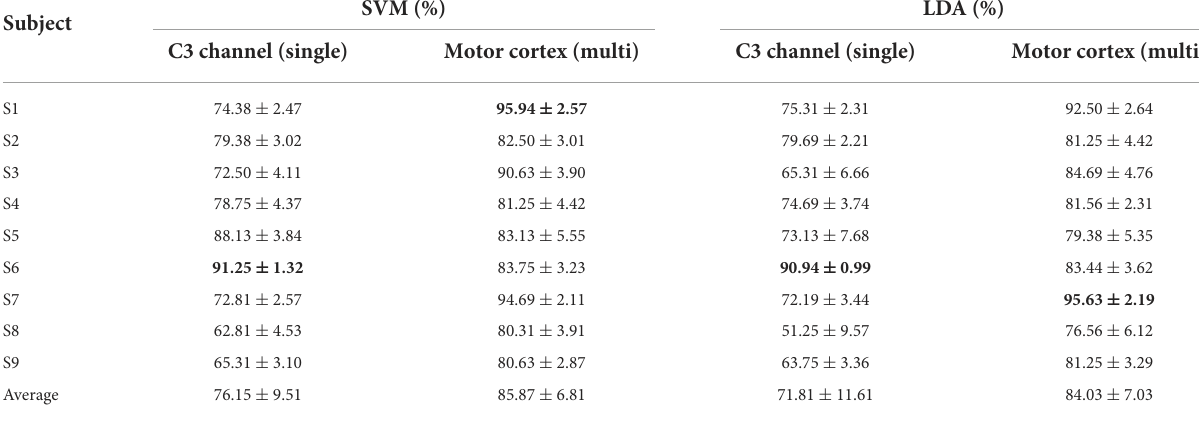
TABLE 3 Griping vs. opening classification based on clustered features.